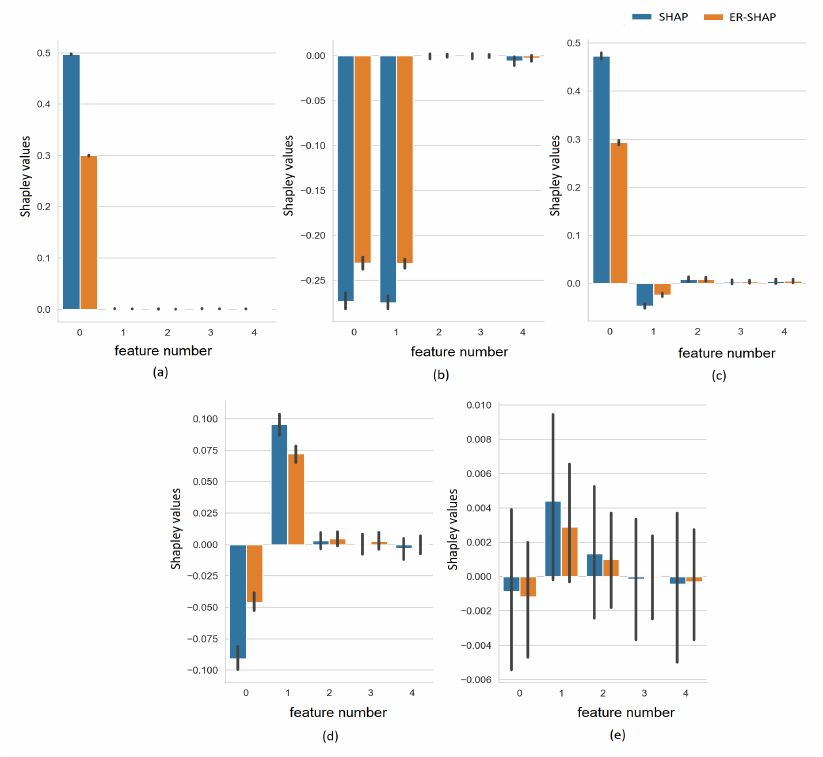
Figure 7. Shapley values obtained by means of SHAP and ER-SHAP for all features of five datasets depicted in corresponding Figure 4a–e and trained SVMs as